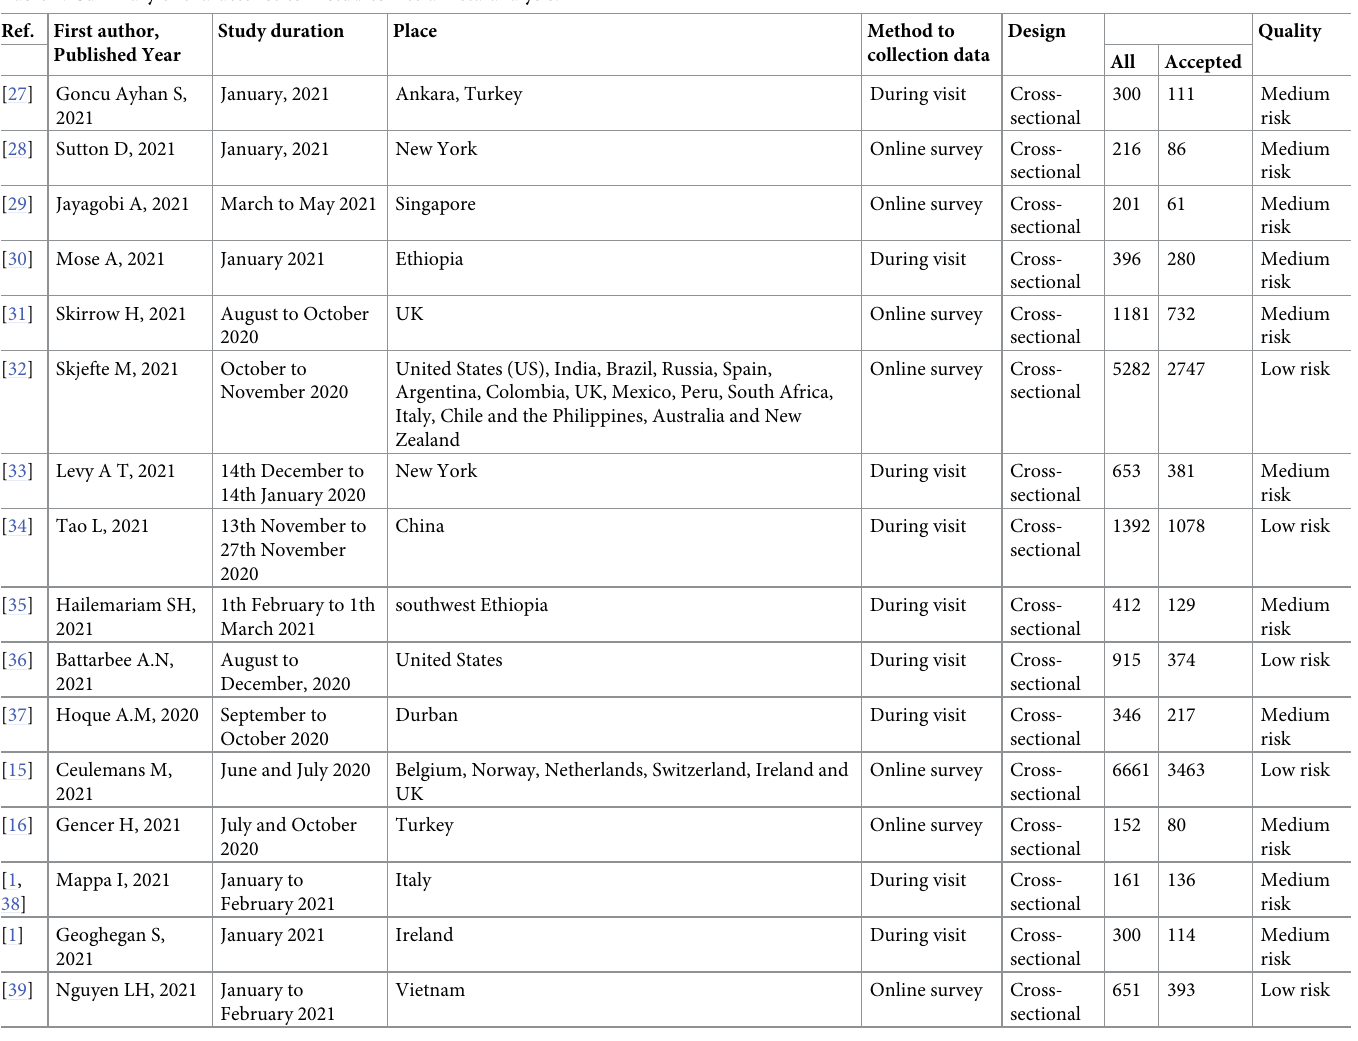
Table 1. Summary of characteristics in studies into a